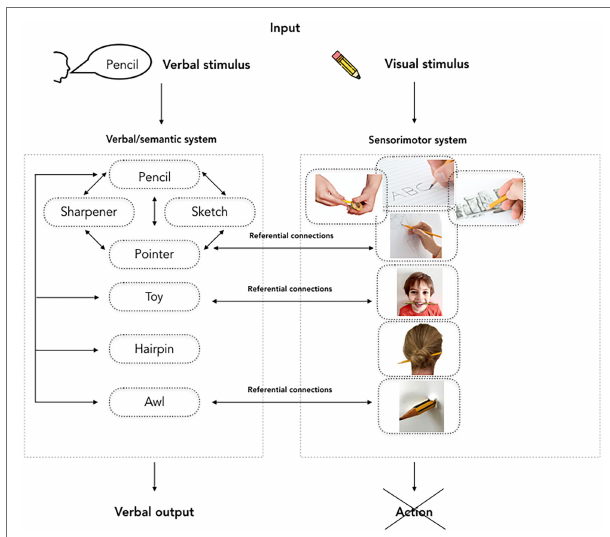
FIGURE 4 | A tentative model of response generation in the AUT. Similar to the naming and action model (Yoon et al., 2002), it posits an interaction between semantic and sensorimotor routes to action. Images sourced with permission from Syda Productions/Adobe Stock; Icefront/Dreamstime; Nfsphoto/Dreamstime; Mishoo/Dreamstime. Other images author’s own